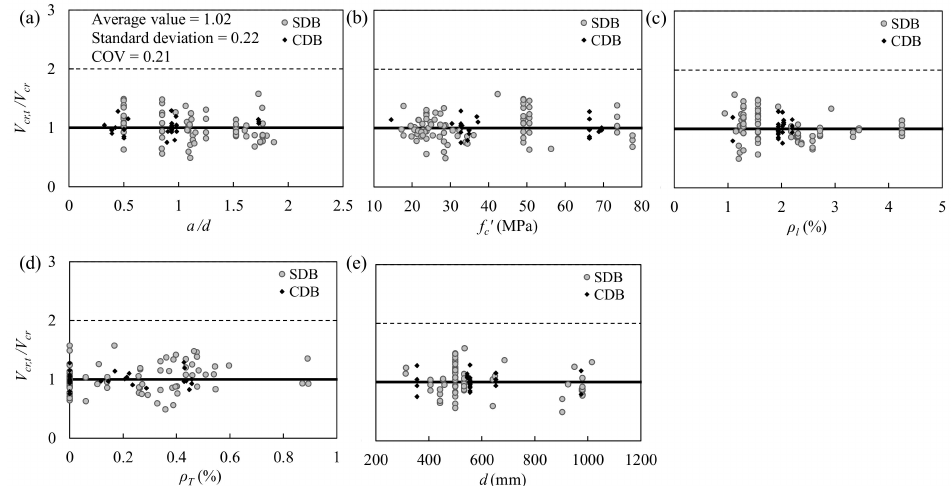
Figure 6. Tested-to-predicted diagonal tension cracking strength ratios V cr,t / V cr by proposed model according to main design parameters. ( a ) Shear span-to-effective depth ratio a / d ; ( b ) concrete compressive strength f c (cid:48) ; ( c ) main tensile reinforcement ratio ρ l ; ( d ) distributed reinforcement ratio ρ T ; ( e ) effective depth d .